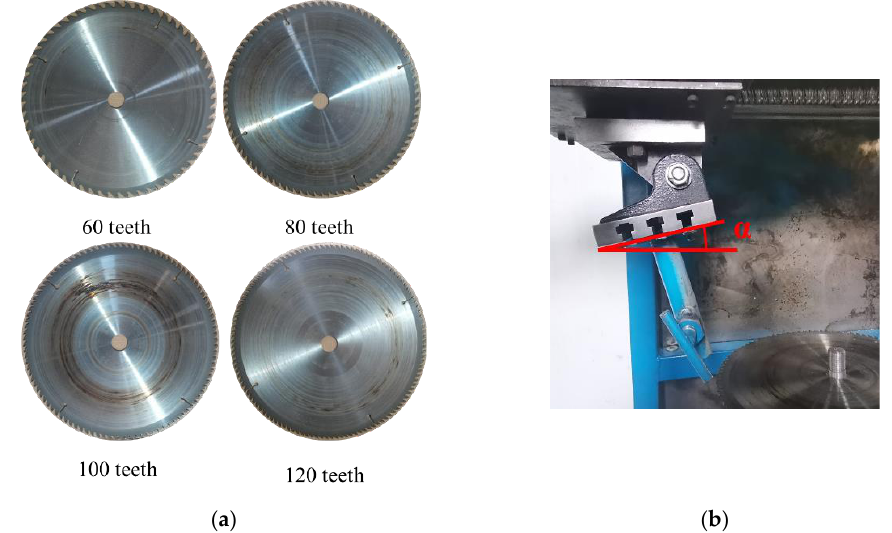
Figure 5. Cutting parameters(( a ) Number of blade teeth; ( b ) Cutting inclination). Figure 5. Cutting parameters (( a ) Number of blade teeth; ( b ) Cutting inclination).